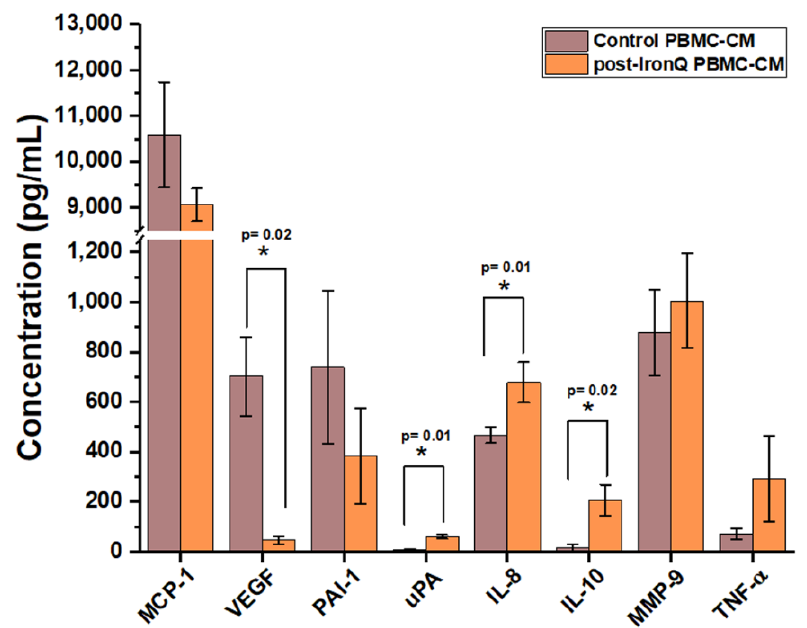
Figure 3. Treatment of PBMCs with the IronQ complex promotes the secretion of vasculogenic, anti-inflammatory, and wound-healing factors. Enzyme-linked immunosorbent assay (ELISA) measurement of cytokines in untreated PBMC-conditioned medium and IronQ-preconditioning PBMC-conditioned medium (at day 10). Data are expressed as means ± SD ( n = 8). PBMCs: peripheral blood mononuclear cells.